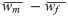
Raw vs. adjusted gender wage gaps.Data details described in section 3. The raw wage gap computed as wm--wf-. The adjusted gender wage gap computed from Oaxaca-Blinder decomposition with the following set of controls: age, education, residence, and marital status. Full set of estimates is discussed in section 4. Estimates obtained separately for each country. The dotted line represents a 45 degree line.